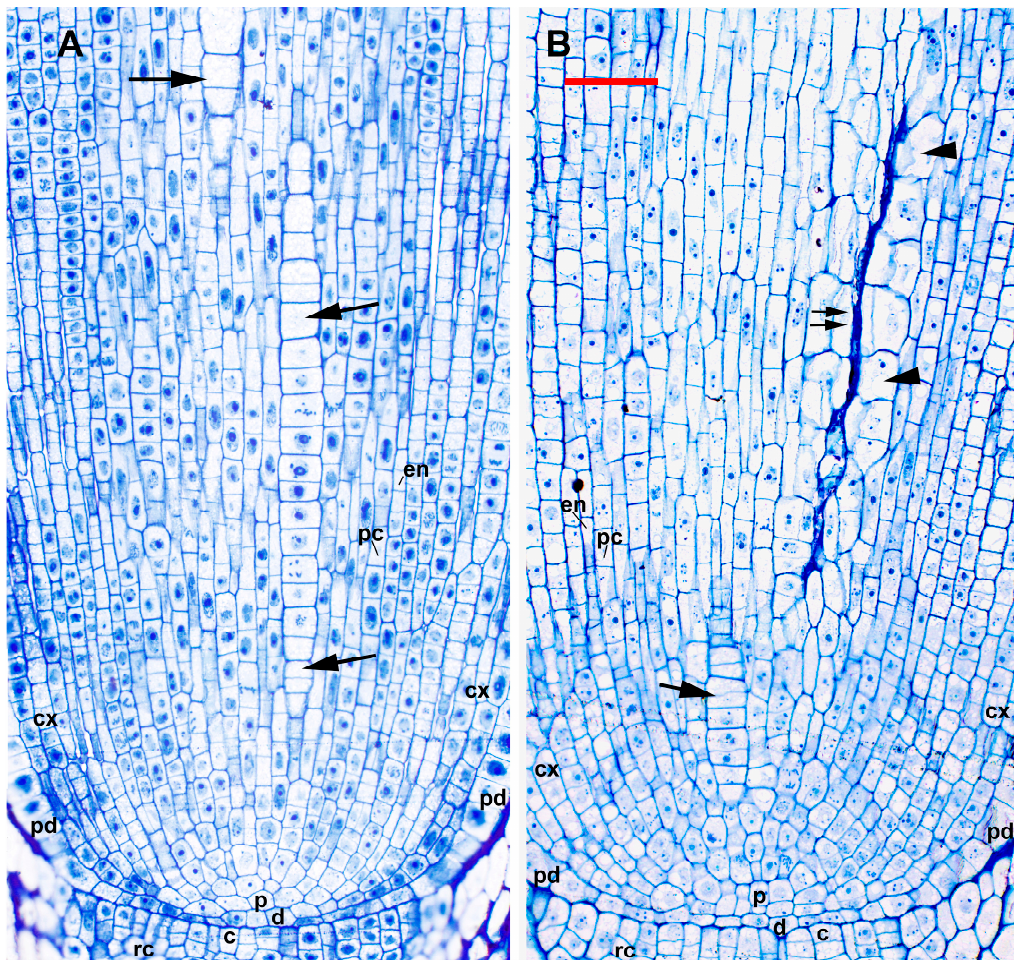
Figure 4. Off-median longitudinal sections showing ( A ) normal LMX (arrows) and ( B ) abnormal (double arrows) LMX vessel development in teosinte root tips. During early development abnormal LMX appear normal. Xylem parenchyma cells surrounding the collapsed elements of an abnormal vessel (arrowheads) are distinctly enlarged and irregular. c, calyptrogen; d. dermatogen/periblem complex; p, plerome; cx, cortex; pc, pericycle; pd, protoderm, en, endodermis; rc, rootcap. Scale bar = 50 µm.